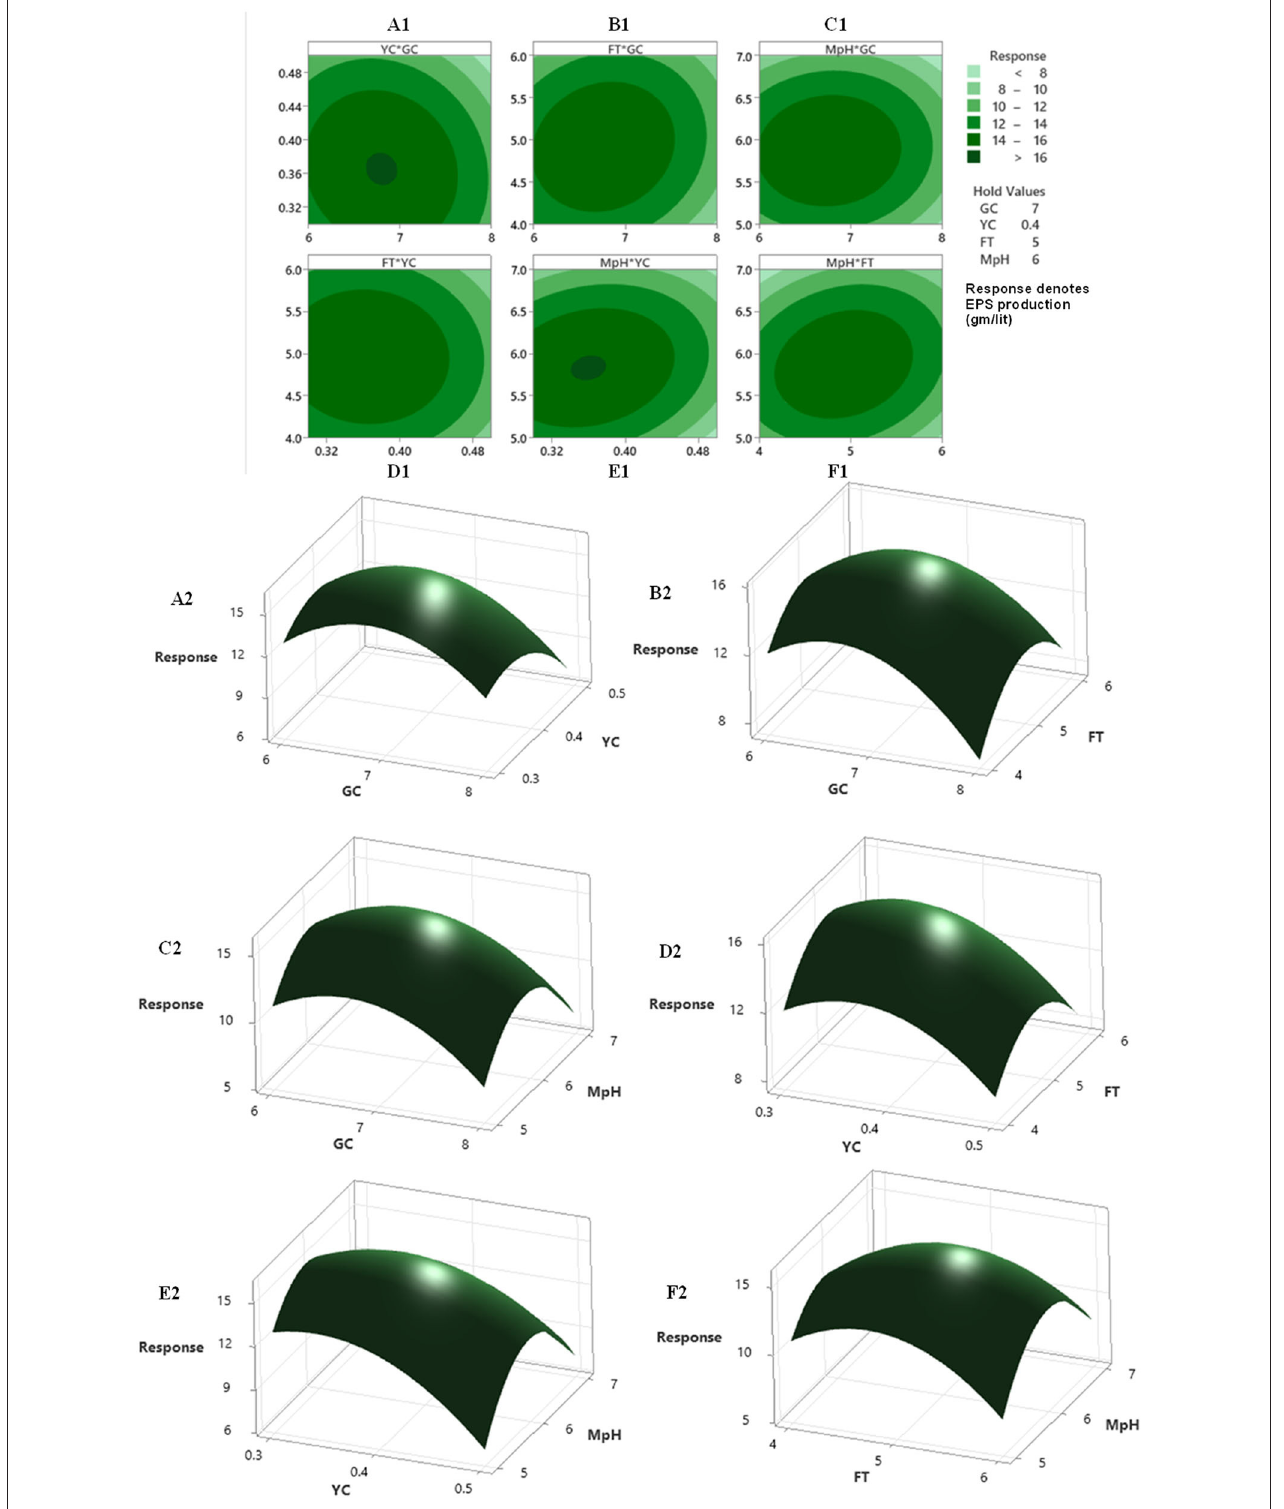
FIGURE 2 | The contour plot and 3D-plot with 2D-projection showing the most important interactions of factors in response surface methodology (RSM) optimization of exopolysaccharide production by Colletotrichum alatae LCS1. (A1,A2) yeast extract concentration (YC)-0.4 gm/lit. vs. glucose concentration (GC)-7 gm/lit. at fermentation time (FT) 5 days and medium pH (MpH) 6. (B1,B2) between FT (5 days) vs. GC (7 gm/lit.) at yeast extract concentration (0.4 gm/lit) and MpH (6). (C1,C2) between MpH (6) vs. GC (7 gm/lit.) at YC (0.4 gm/lit.) and FT (5 days). (D1,D2) between FT (5 days) vs. YC (0.4 gm/lit.) at GC (7 gm/lit.) and MpH (6). (E1,E2) between MpH(6) vs. YC (0.4 gm/lit.) at GC (7 gm/lit.) and FT (5 days). (F1,F2) between MpH vs. FT (5 days) at GC (7 gm/lit.) and YC (0.4 gm/lit.).